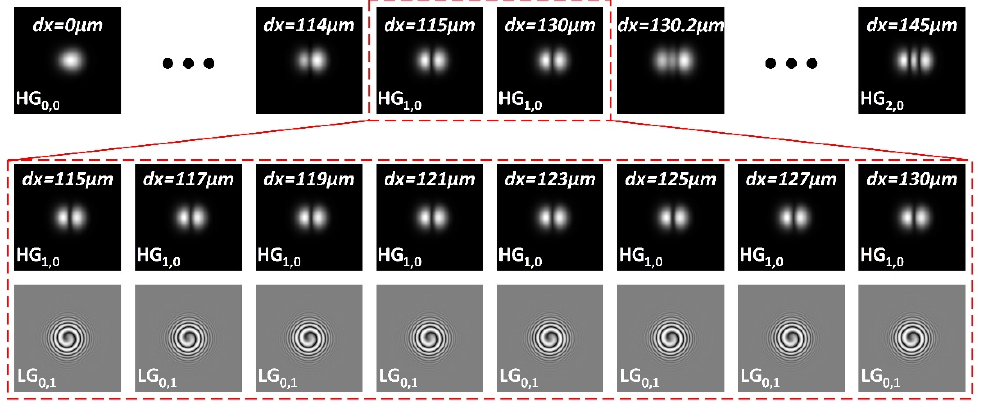
Figure 12. Stable region for the HG 1,0 beam.